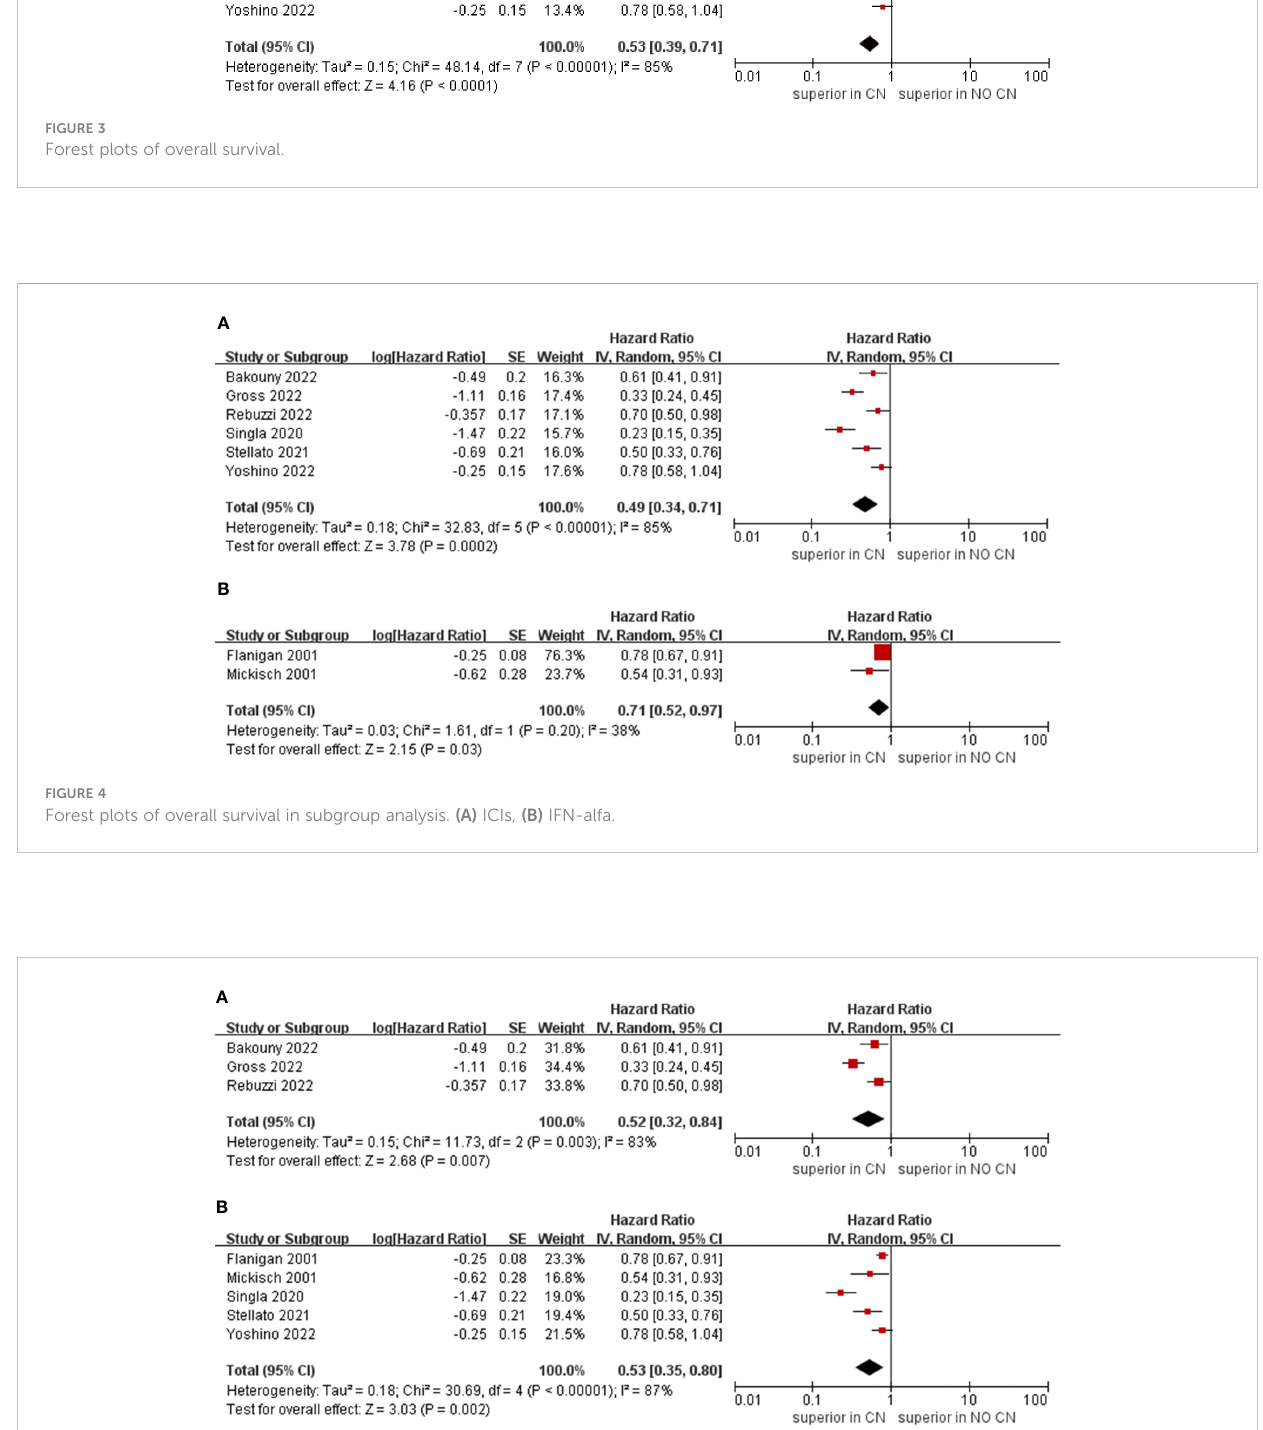
FIGURE 5 Forest plots of overall survival in subgroup analysis. (A) sample size > 400, (B) sample size ≤